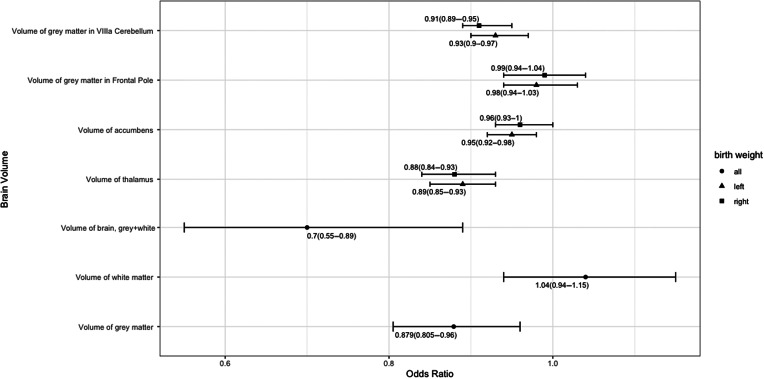
Association between depression and brain volume. The x-axis refers to odds ratio (OR). The y-axis represents the exposure variables. Points display the OR and 95% confidence intervals (CIs) (error bars) of OR. Detail information is showed in Table S3 in the Supplementary Material.